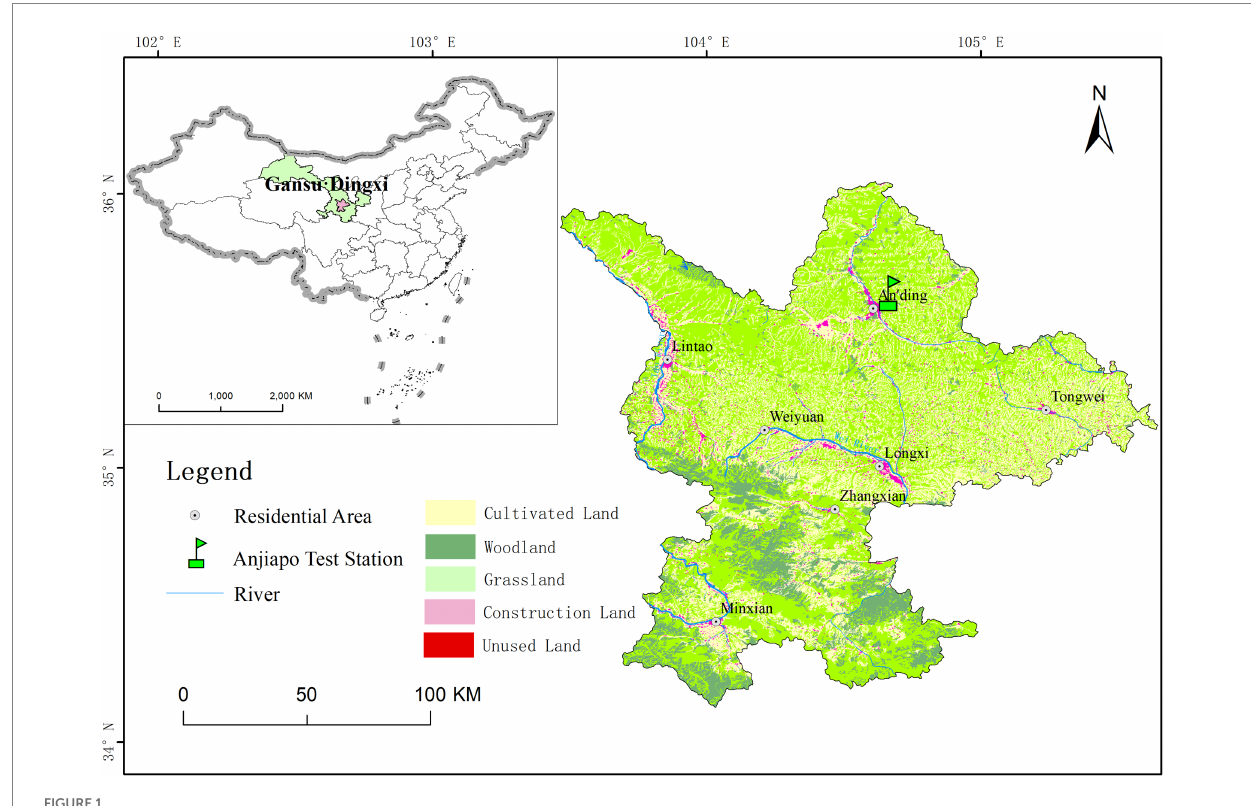
FIGURE 1 Geographical map of the study area in the Loess Plateau of